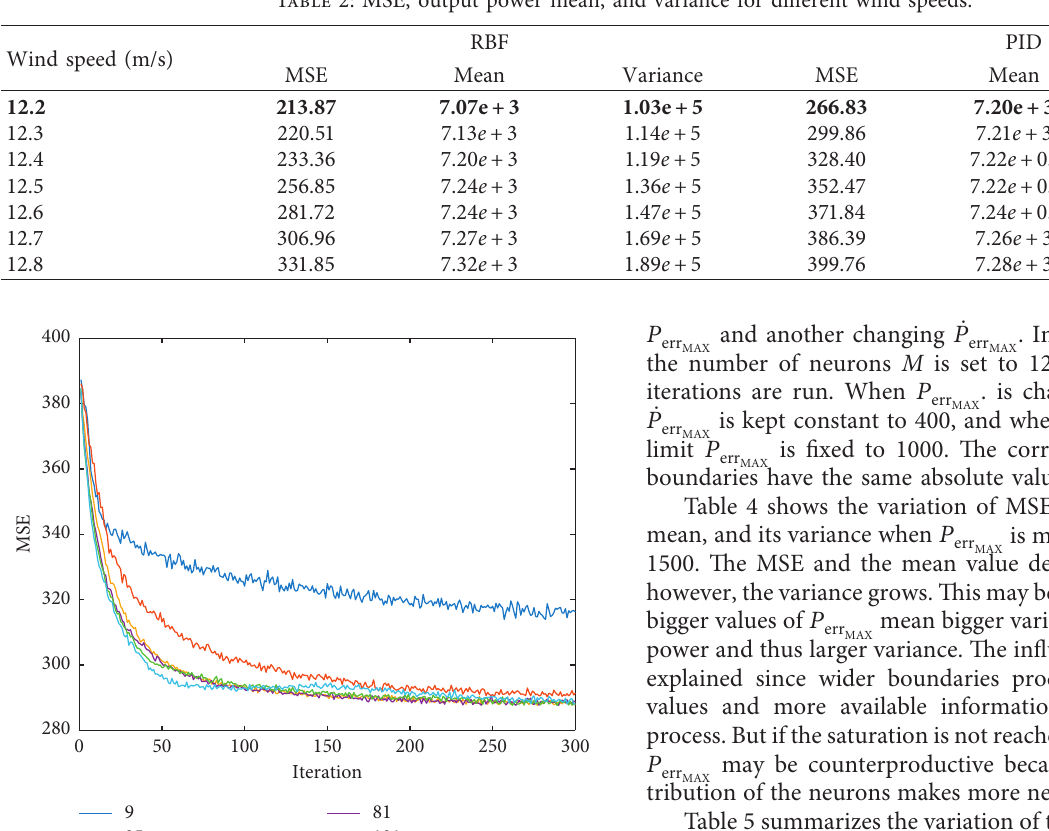
Table 2: MSE, output power mean, and variance for different wind speeds.